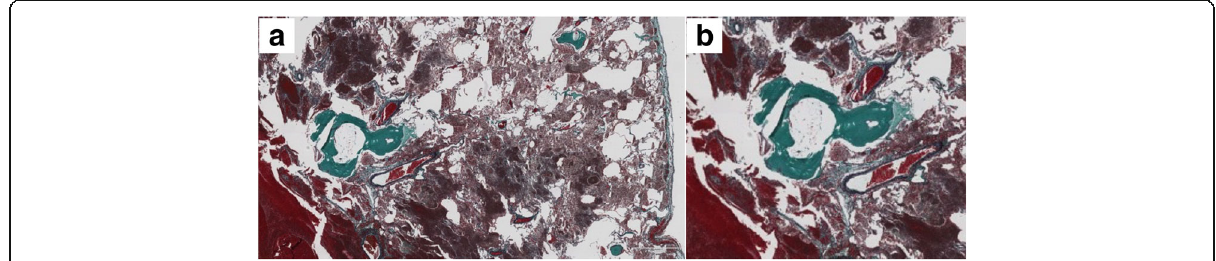
Fig. 6 Multiple ossified areas with bone marrow formation are observed around the hematoma. a Elastica Masson-Goldner-stained section under low magnification. b Elastica Masson-Goldner-stained section under high